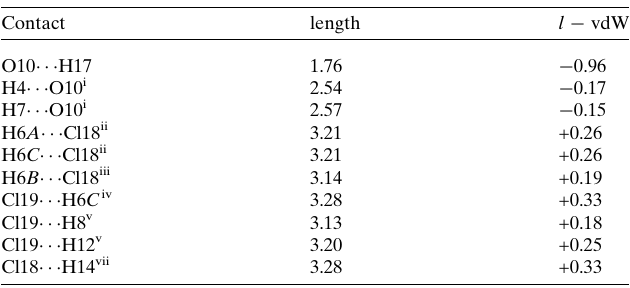
Table 2 Short contacts (A˚ ) in the crystal structure of the title compound.